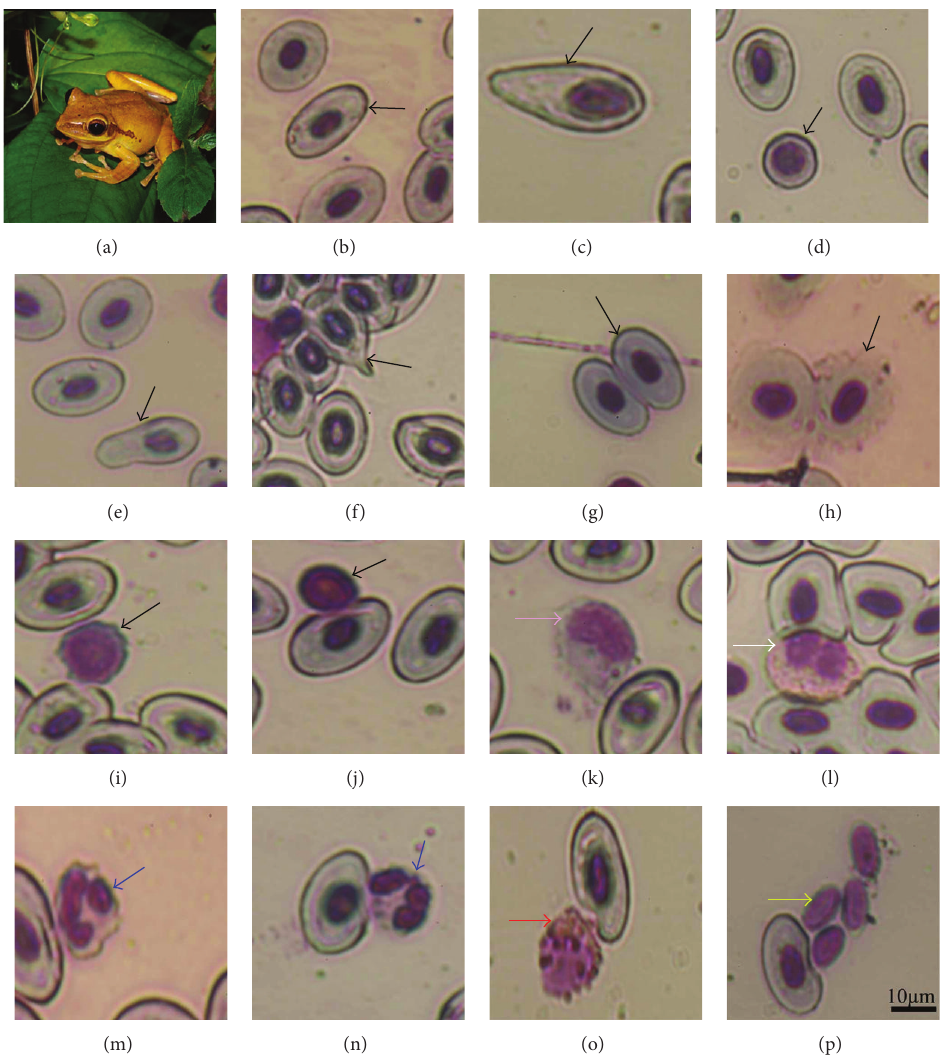
Figure 1: (a) Adult Polypedates teraiensis , (b) elliptical RBC with centrally placed nucleus, (c) elliptical RBC with eccentrically placed nucleus, (d) circular RBC with centrally placed nucleus, (e) spindle-shaped RBC, (f) teardrop-shaped cell, (g) dividing erythrocytes, (h) destruction of erythrocytes’ membrane, (i) large lymphocyte, (j) small lymphocyte, (k) monocyte, (l) eosinophil, (m) tetralobed neutrophil, (n) trilobed neutrophil, (o) basophil, and (p) cluster of thrombocytes (scale bar = 10 𝜇 m,